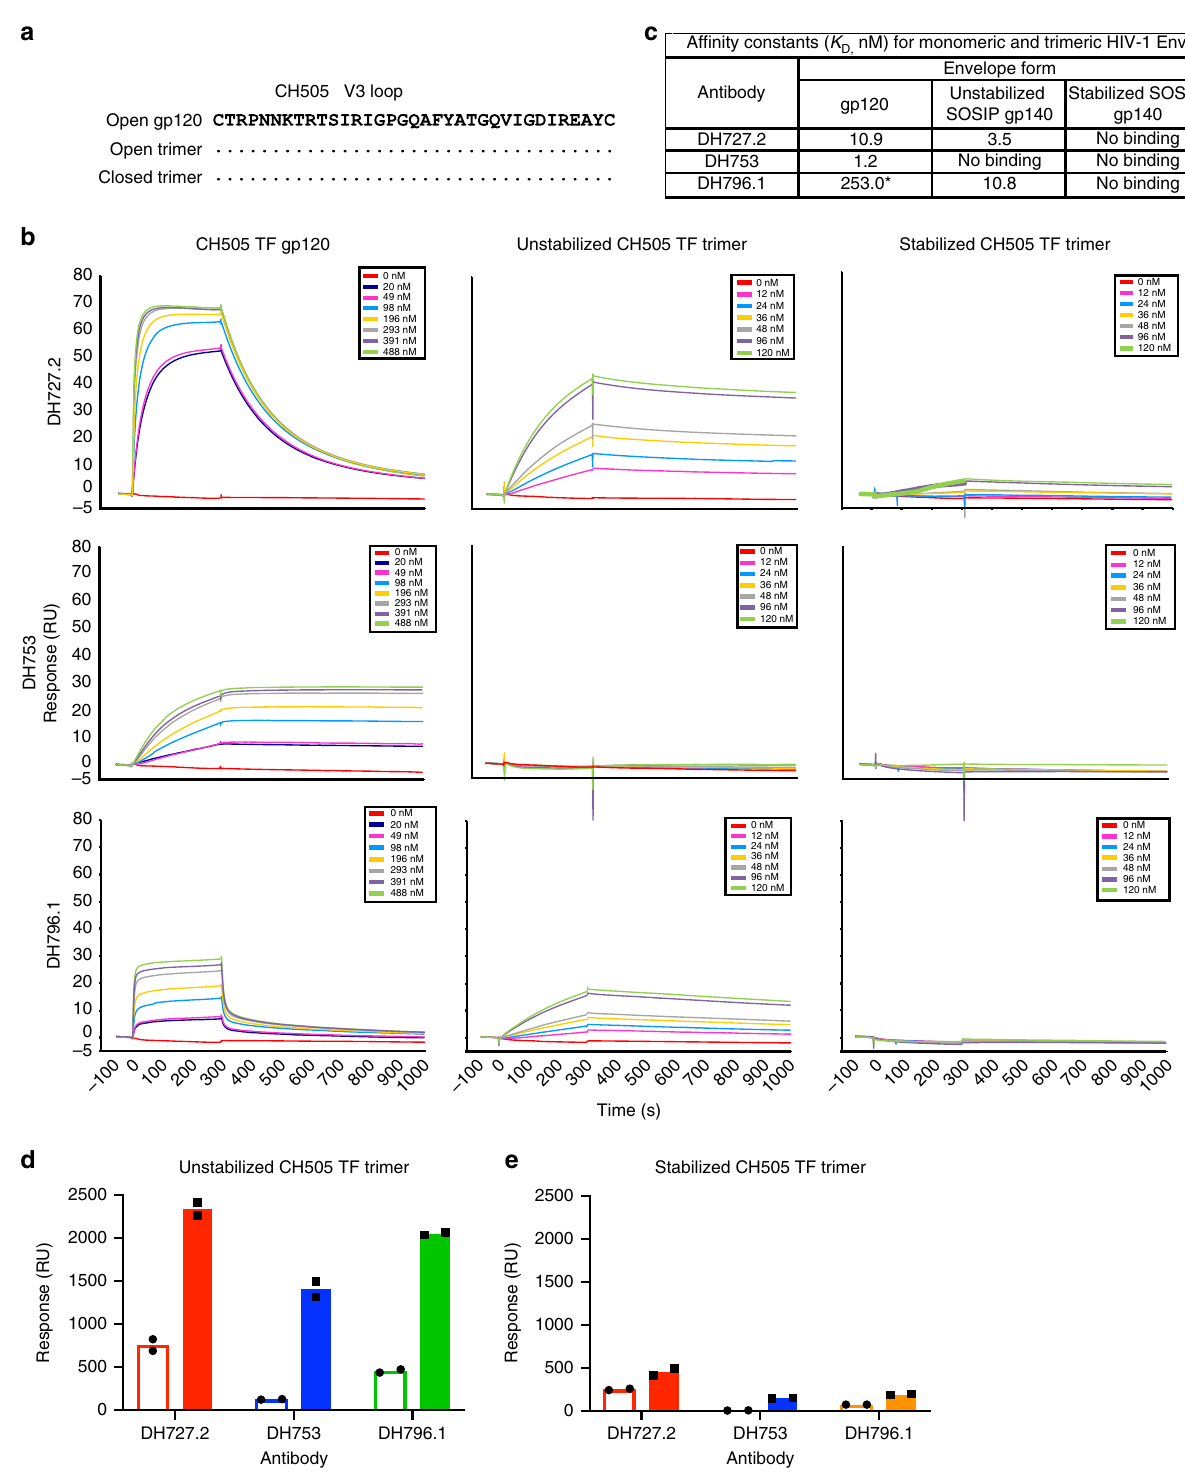
Crystallography . Fabs were expressed in transiently-transfected Expi293 cells (Invitrogen, Cat No. A14527) 54 . The Fab was puri fi ed by KappaSelect af fi nity chromatography. The Fab was eluted off of the KappaSelect resin with a glycine pH2.4 buffer and the pH was subsequently neutralized by the addition of Tris pH8.0. The Fab was then further puri fi ed via size exclusion chromatography. Peak protein-containing fractions were concentrated, buffer exchanged to ddH2O,